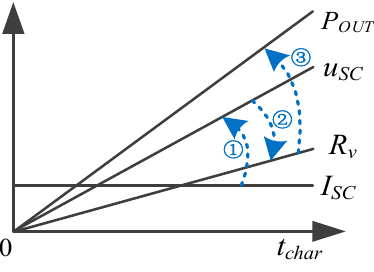
Figure 4. Relationship between some key parameters.